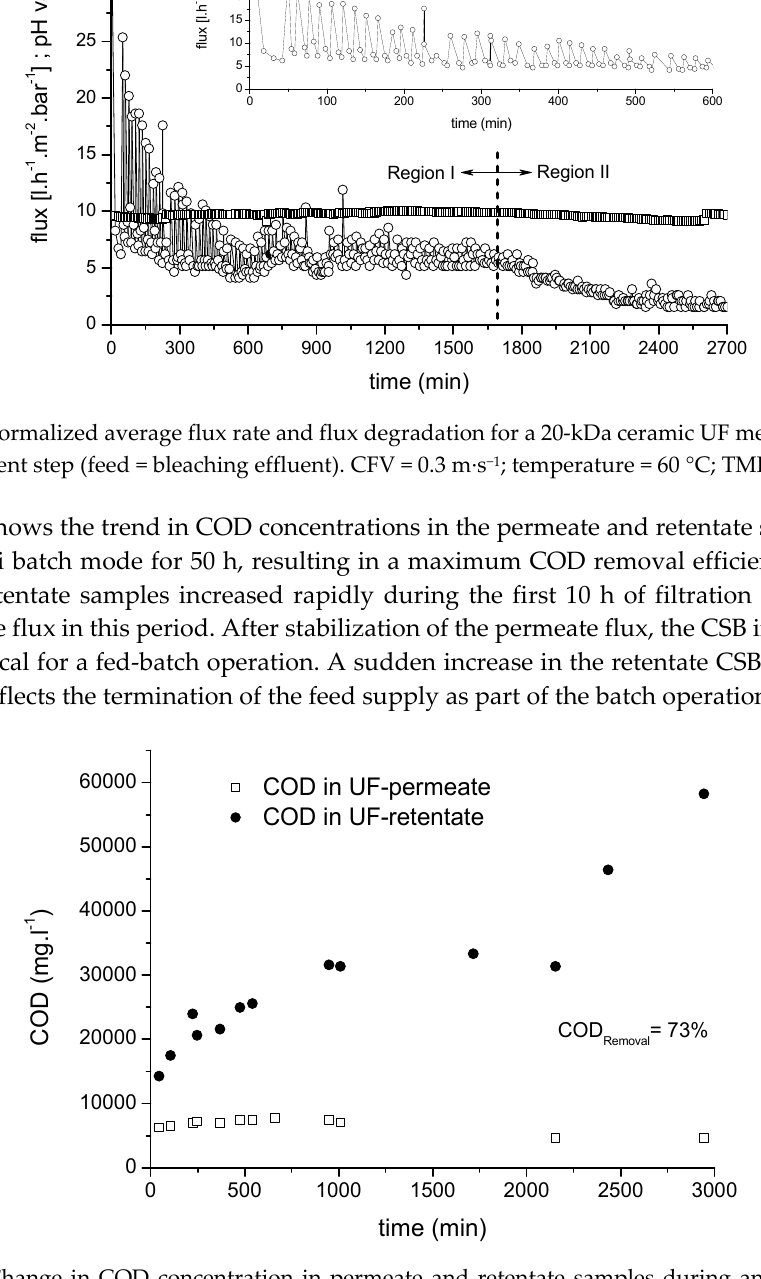
Figure 9. Change in COD concentration in permeate and retentate samples during an UF process (20-kDa membrane) using MF permeate as the